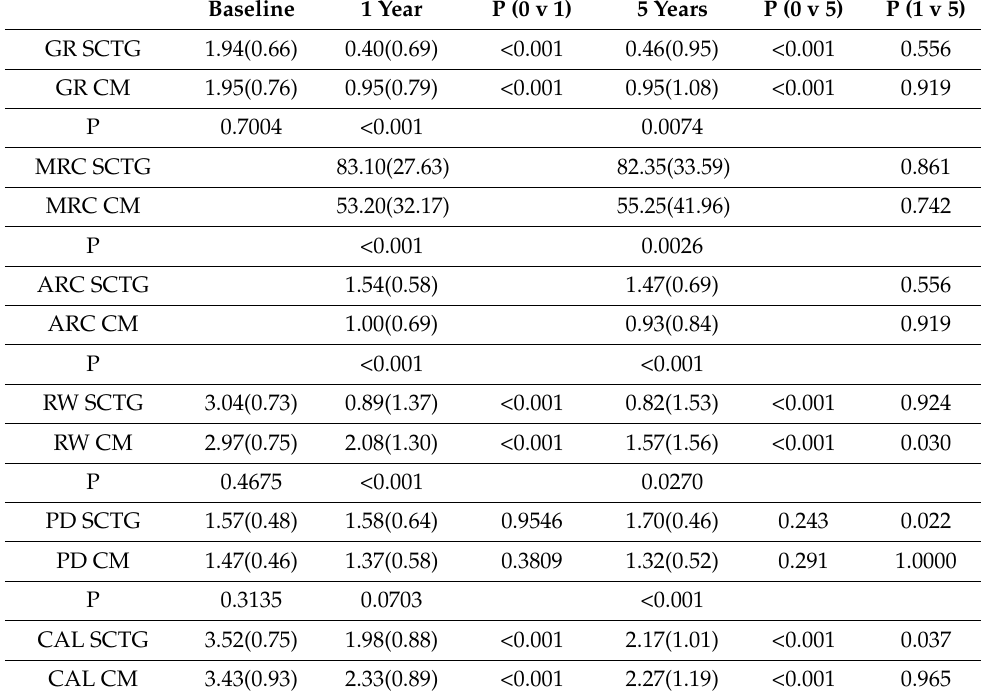
Table 1. Clinical parameters (mean and SD) at baseline and at 1 year and 5 years post-surgery.